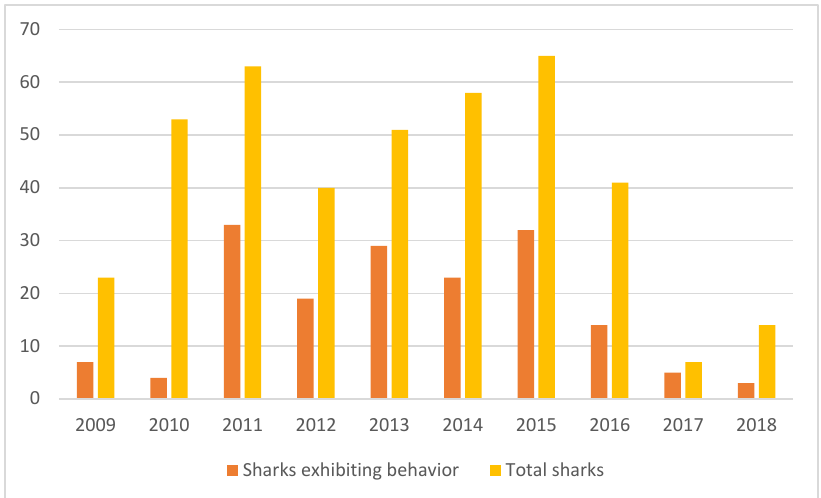
Figure 3. White sharks ( Carcharodon carcharias ) exhibiting social behavior each year and the total number of white sharks sighted per